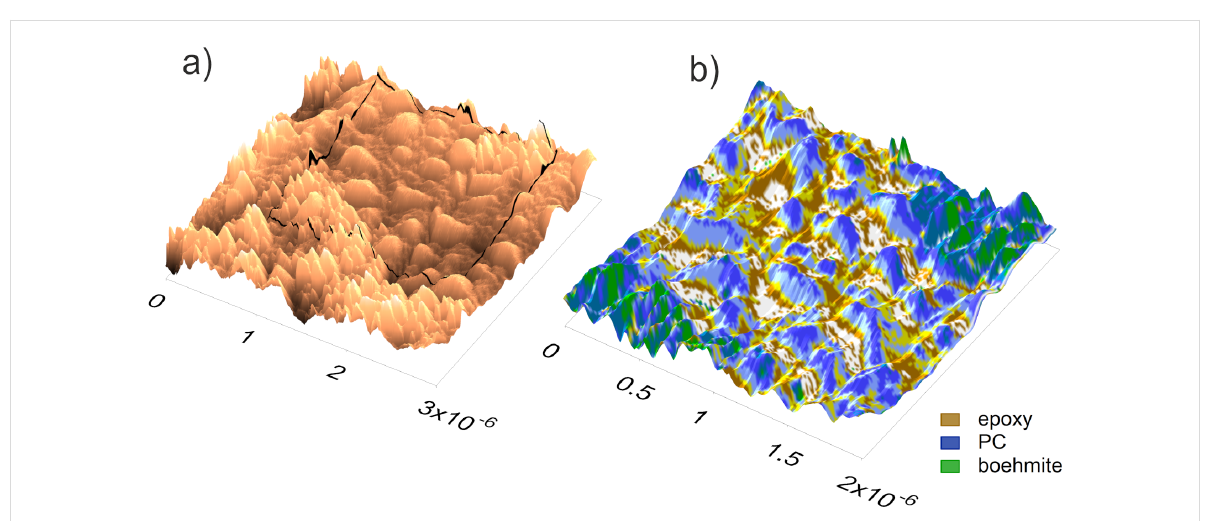
Figure 8: (a) AFM tapping topography, the black line indicates the position of (b). (b) mPCA via ImAFM ADFS measurements and F attr deconvolution (spatial domain). PC (blue) is dissolved by epoxy (brown) but boehmite NPs (green) are not released into the epoxy matrix. The measurements were performed with the tip